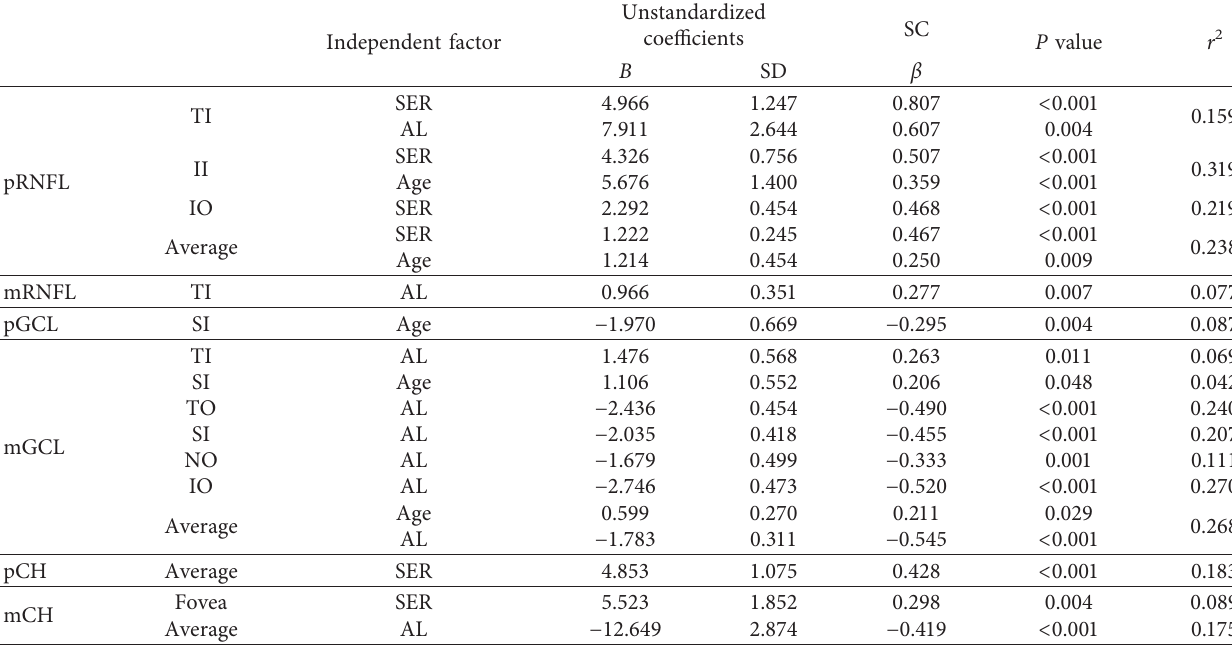
Table 4: Correlations between the retina, RNFL, ganglion cell layer, and choroid thickness and spherical equivalent, age, and axial length. Independent